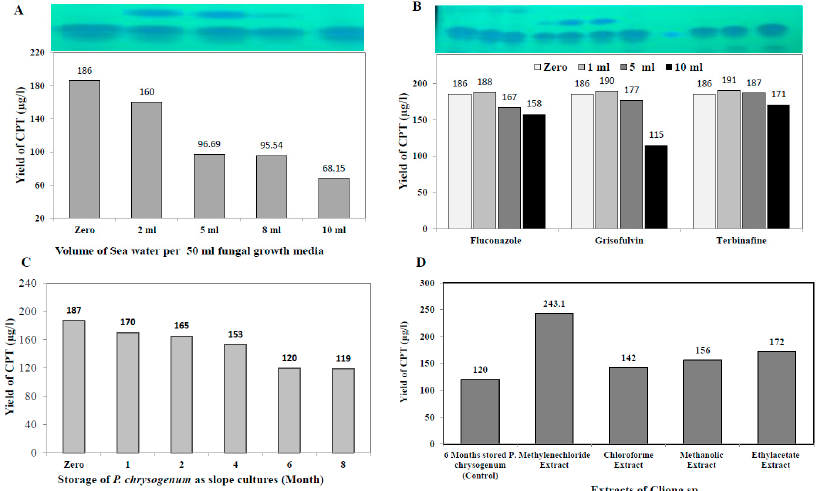
Figure 6. Effect of sea water concentration and growth inhibitors on camptothecin productivity for P. chrysogenum . The yield of camptothecin for P. chrysogenum in response to different sea water con- centration ( A ), and growth inhibitors Grisofulvin, terbinafine ( B ). ( C ) The productivity of camptoth- ecin for P. chrysogenum in response to fungal storage periods as slope culture. ( D ) The yield of camp- tothecin for P. chrysogenum in response to amendment with different extracts of Cliona sp.